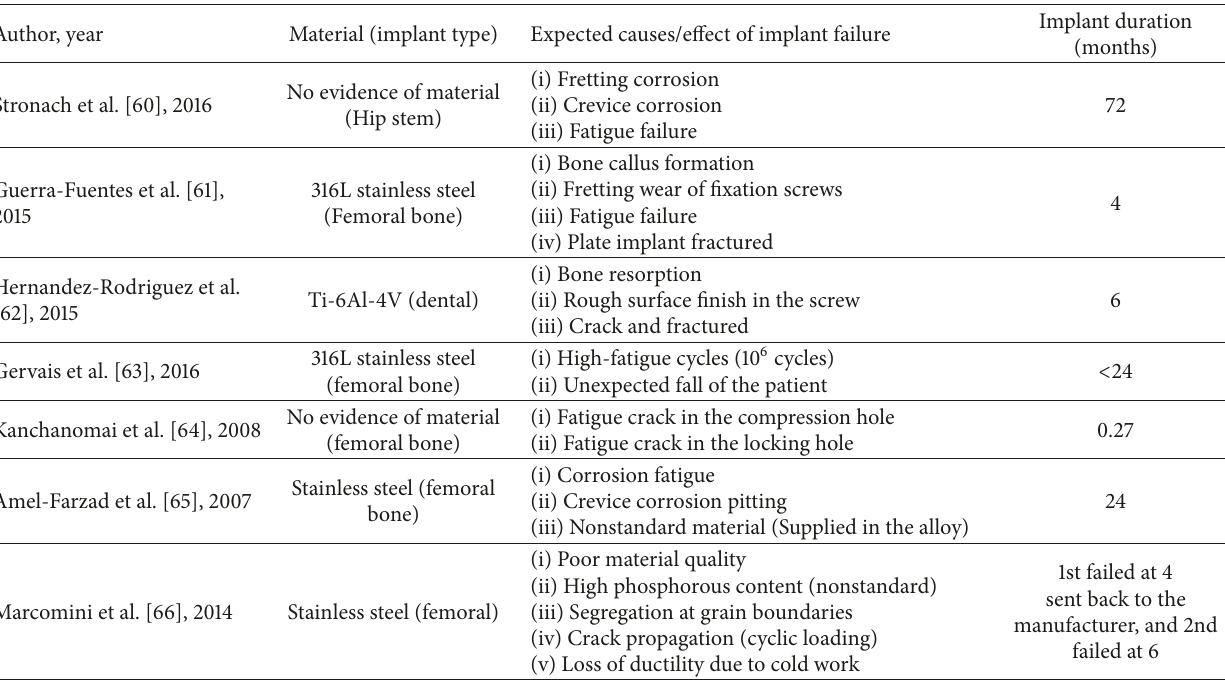
Table 3: Critical review on some premutually failed orthopedic and dental implants.